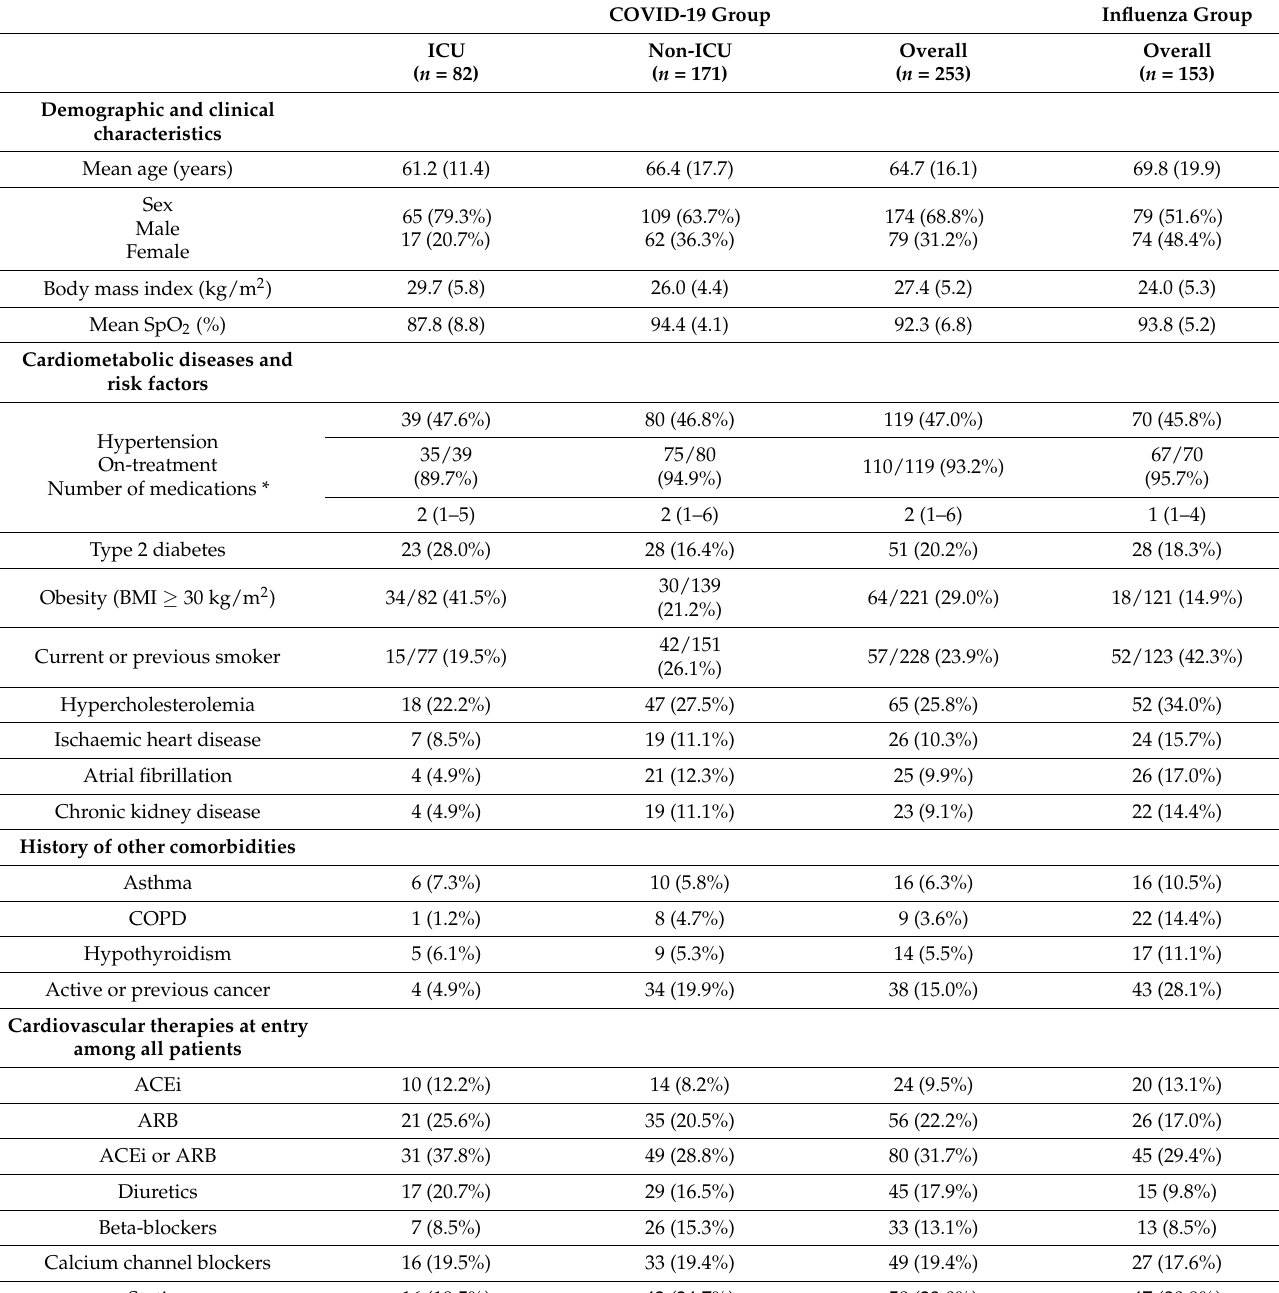
Table 1. Demographic and clinical characteristics, comorbidities, and cardiovascular therapies of COVID-19